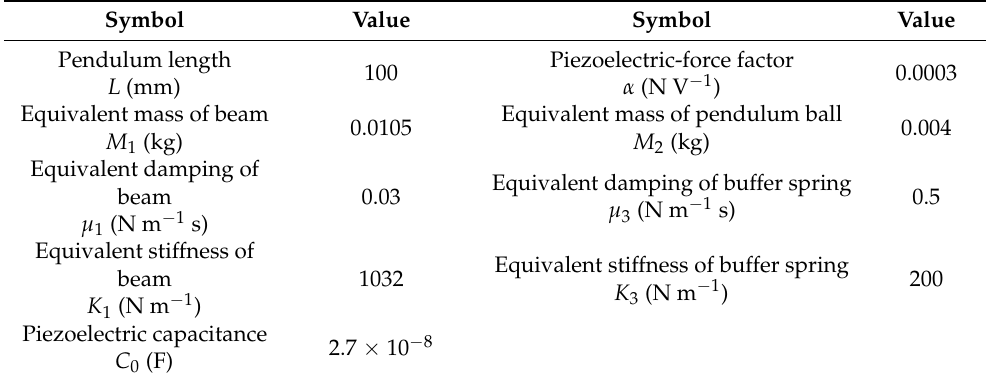
Table 1. Parameters for the proposed prototype.